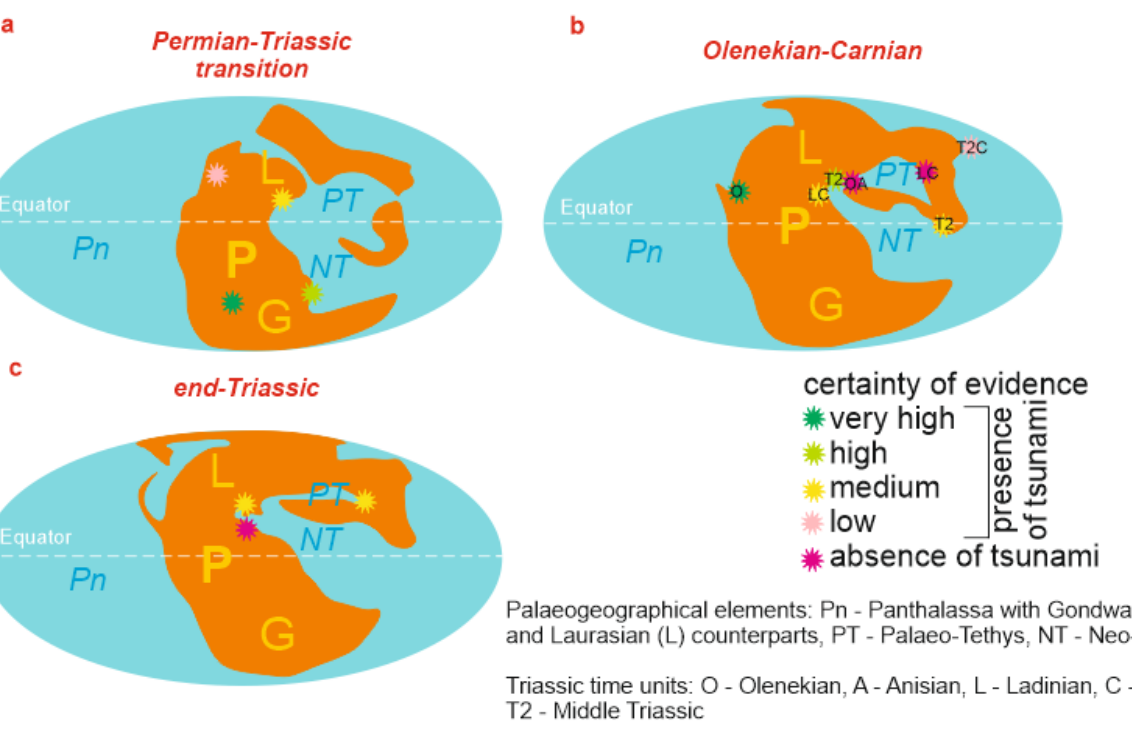
Figure 3. Global distribution and certainty of evidence of palaeotsunamis from the three time slices of the Triassic Period (configurations of continental blocks are strongly simplified from [48]).